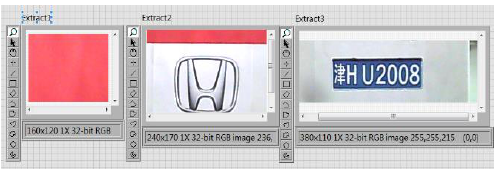
Figure 24. Image segmentation result.